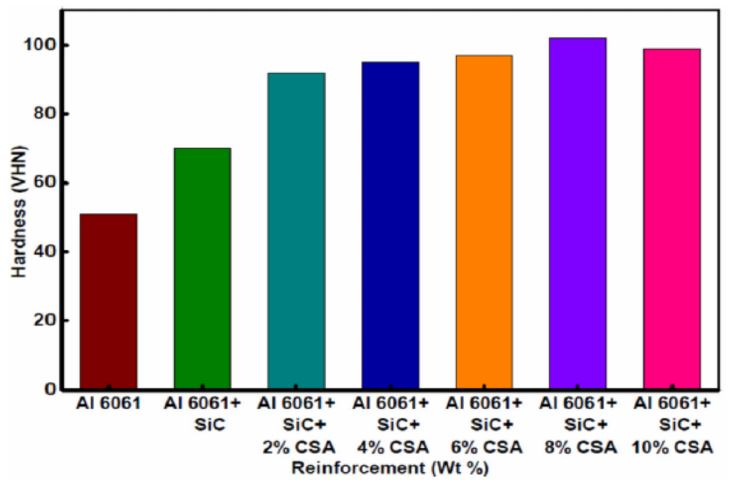
Figure 12. Hardness values of Al6061 and its composites